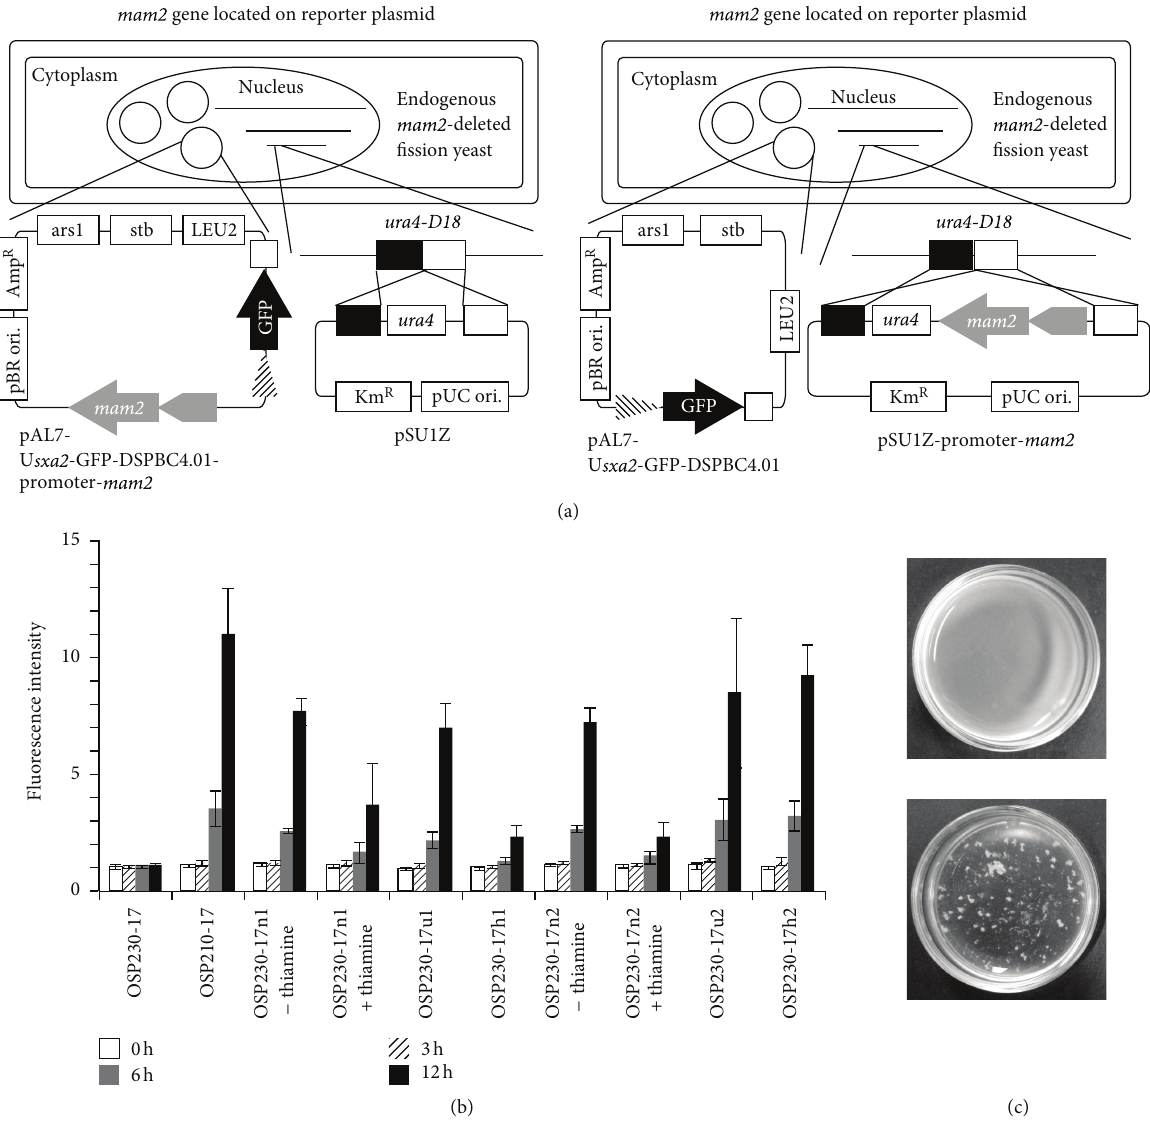
F 4: Ectopic mam2 expression in